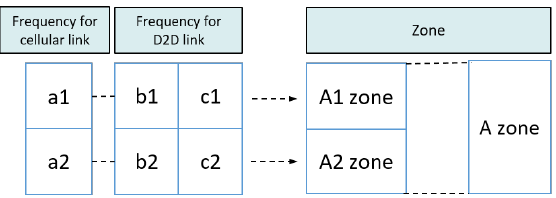
Figure 5. Frequency allocation to cellular links in FFR-3.